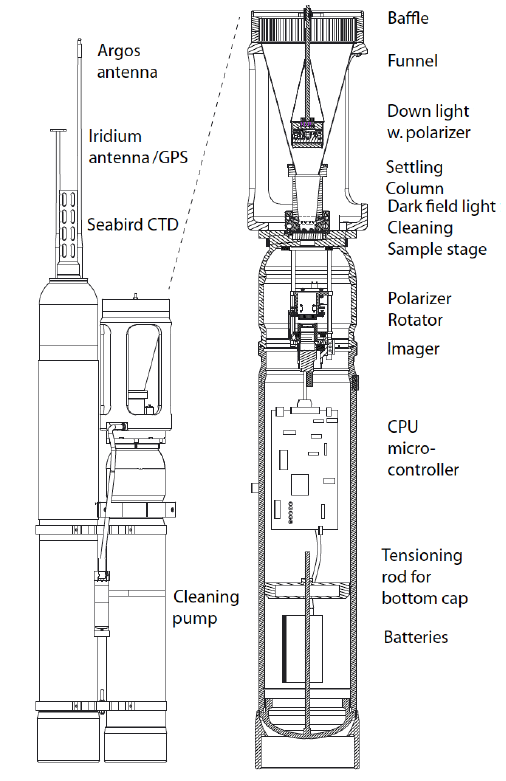
Figure A1. Drawing depicting the configuration of CFE001 and de- tail of lighting and imaging elements of the OSR. During operation, the OSR uses a three-axis accelerometer to monitor system